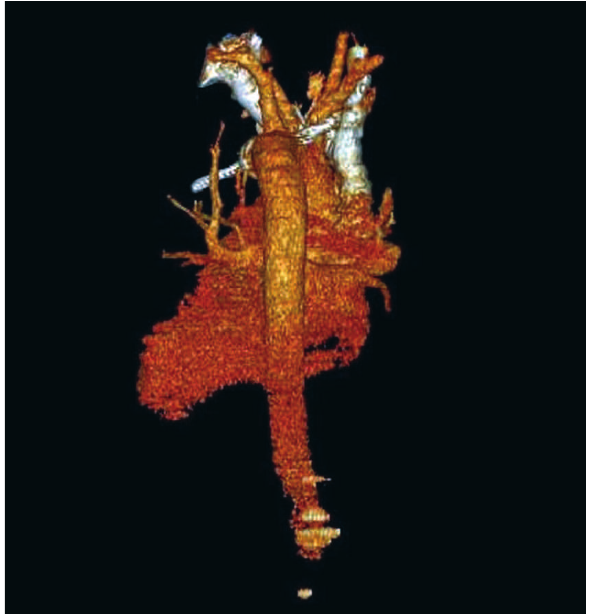
Fig. 3 - Tomografia de tórax com reconstrução tridimensional, com corpo estranho transfixando aorta torácica